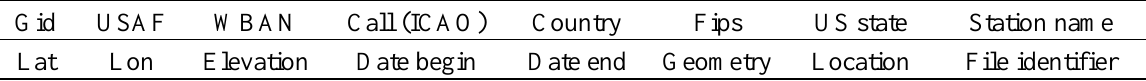
Table 6. Fields of database table with overview of integrated meteorological